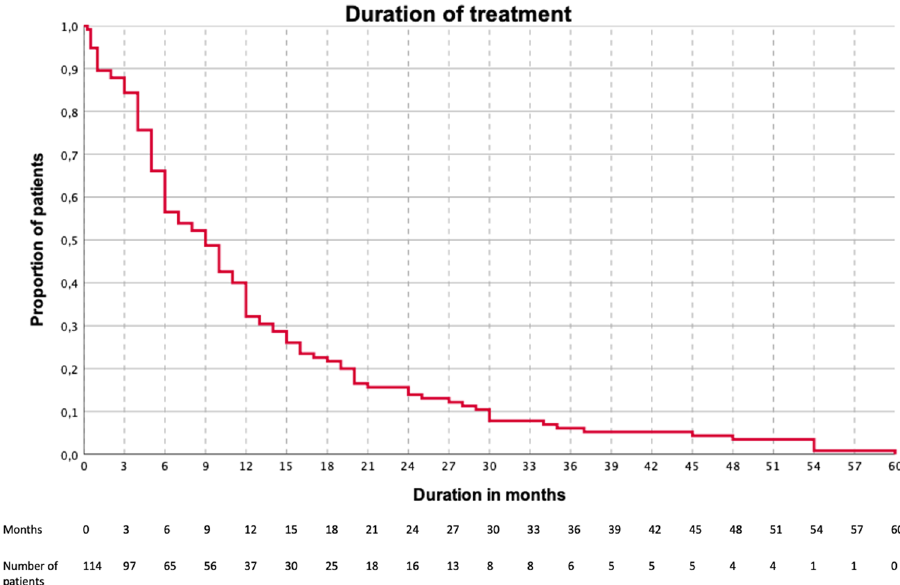
Figure 4. Kaplan–Meier survival curve showing the duration of candesartan treatment. X-axis, duration in months; Y-axis, the proportion of patients (n =